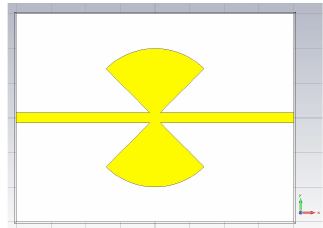
Figure 25: Comparisons of E-field (a) and H-field (b) components obtained by the dipoles model and HFSS in the frequency-domain.